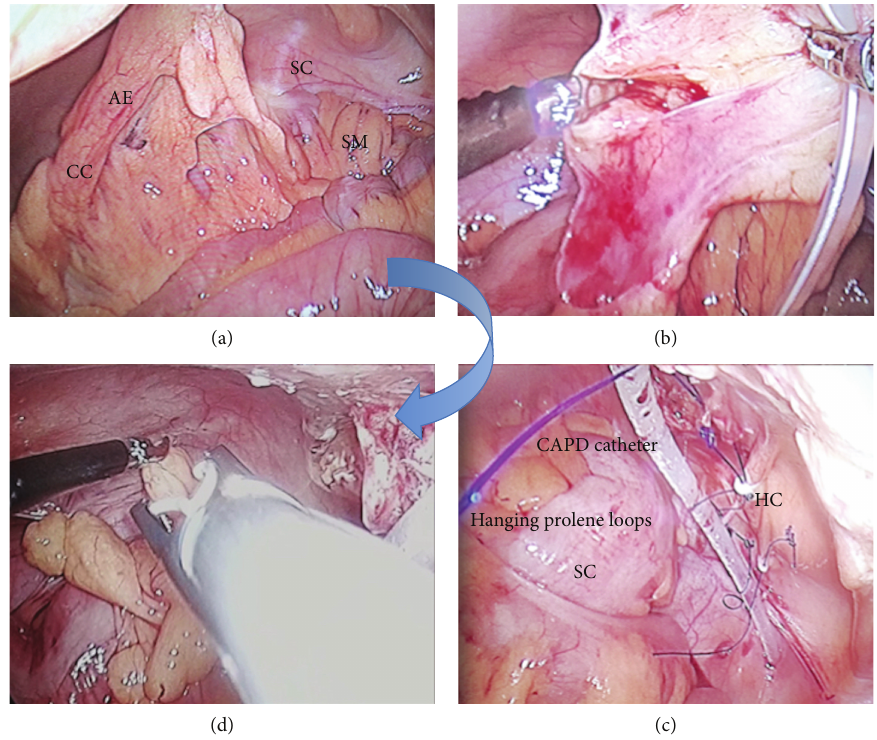
Figure 2: Laparoscopic view demonstrating wrapped-up CAPD catheter by appendices epiploicae of sigmoid colon (a). Dissection of the catheter from epiploicae using harmonic shear device (b). CAPD catheter hanging freely over prolene loops that are fixed to the pelvic parietal peritoneum using hemostatic clips (c). Epiplopexy using hemostatic clips (d) (AE = appendices epiploicae; CC = CAPD catheter; SC = sigmoid colon; SM = sigmoid mesocolon; HC = hemostatic